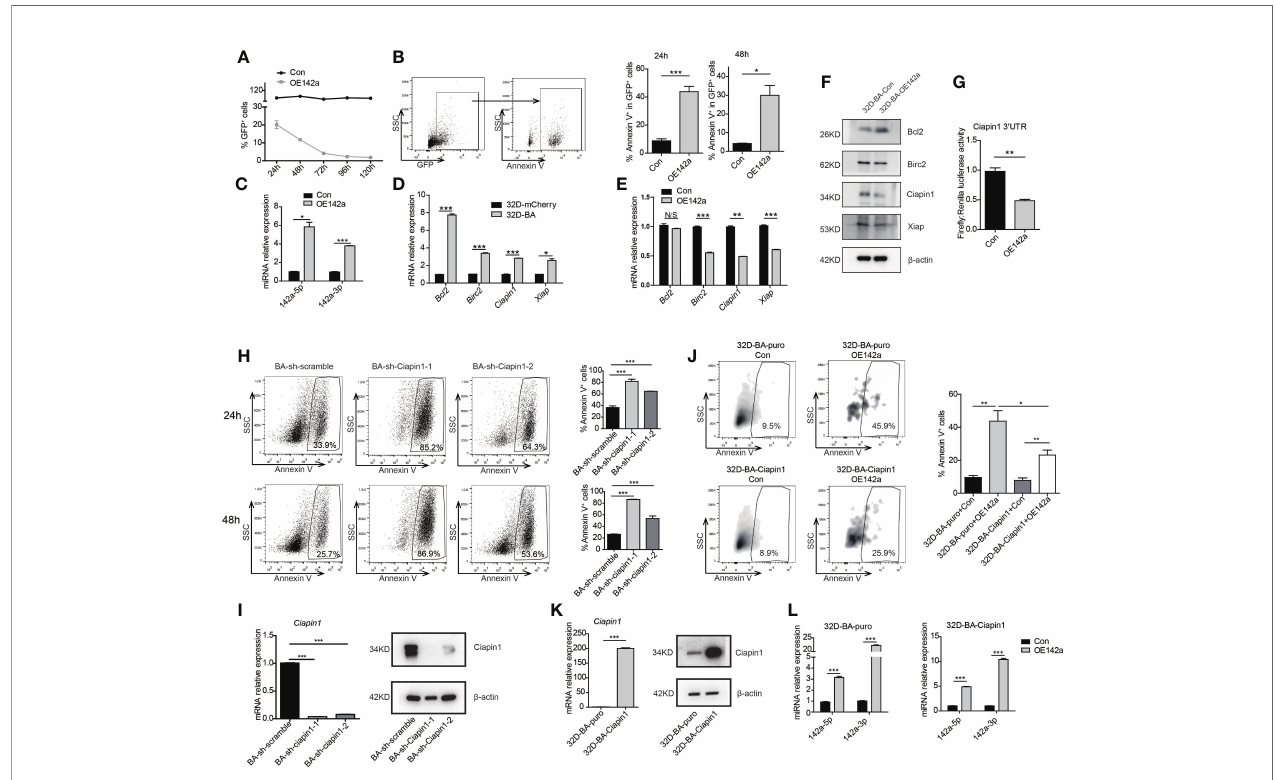
FIGURE 5 | Overexpression of miR-142a impaired cell viability partially through targeting Ciapin1. (A) Follow-up analysis of GFP + cell proportion in 32D-BA cells infected with pCDH-EF1-miR142a-T2A-copGFP virus. (B) Apoptosis analysis of 32D-BA cells at 24h and 48h after lentivirus infection. (C) Validation of miR-142a-5p and miR-142a-3p expression by qRT-PCR. (D, E) qRT-PCR detection of anti-apoptotic gene Bcl2, Birc2, Ciapin1, and Xiap in 32D-BA cells (D) and miR-142a- overexpressed (OE142a) 32D-BA cells (E) . (F) Western blot detection of anti-apoptotic proteins Bcl2, Birc2, Ciapin1, and Xiap in 32D-BA cells infected with lentivirus encoding miR-142a. (G) Identi fi cation of miR-142a target gene by luciferase reporter assay. (H) Apoptosis analysis of 32D-BA cells at 24h and 48h after Ciapin1 knockdown. (I) Determination of Ciapin1 expression by qRT-PCR and western blot analysis. (J) Comparative analysis of apoptosis between 32D-BA-puro+OE142a and 32D-BA-Ciapin1+OE142a cells via Annexin V staining. (K) Validation of Ciapin1 expression by qRT-PCR and Western blot assay. (L) Validation of miR-142a-5p and miR-142a-3p expression in 32D-BA-puro and 32D-BA-Ciapin1 cells by qRT-PCR. Results are mean ± SEM, *p < 0.05, **p < 0.01, ***p < 0.001 and N/S (not signi fi cant) (B – E, G – L) was assessed by unpaired t